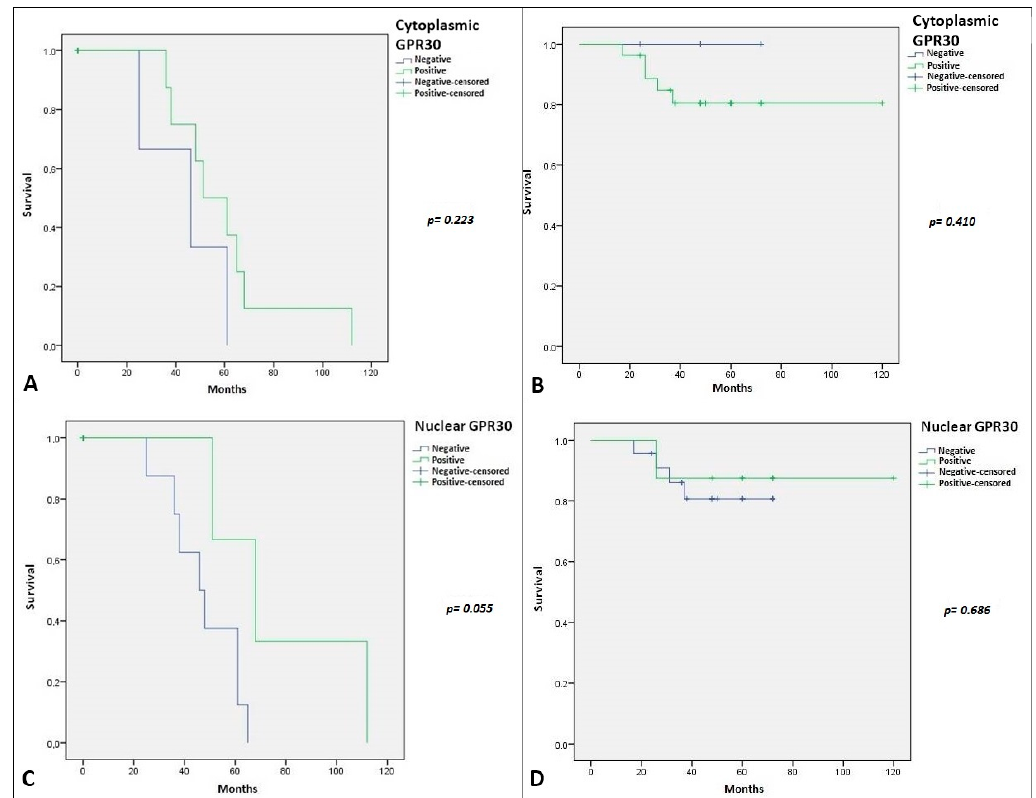
Figure 8. ( A ) Kaplan–Meier plot for disease-free survival (DFS) in patients with SGT stratified by Cytoplasmic GPR30 IHC expression. The green line represents patients with Cytoplasmic GPR30 positivity; ( B ) Kaplan–Meier plot for overall survival (OS) in patients with SGT stratified by GPR30 IHC expression. The green line represents patients with Cytoplasmic GPR30 positivity; ( C ) Kaplan–Meier plot for DFS in patients with SGT stratified by Nuclear GPR30 IHC expression ( p -value = 0.055). The green line represents patients with Nuclear GPR30positivity; ( D ) Kaplan–Meier plot for OS in patients with SGT stratified by Nuclear GPR30 IHC expression. The green line represents patients with Nuclear GPR30 positivity.